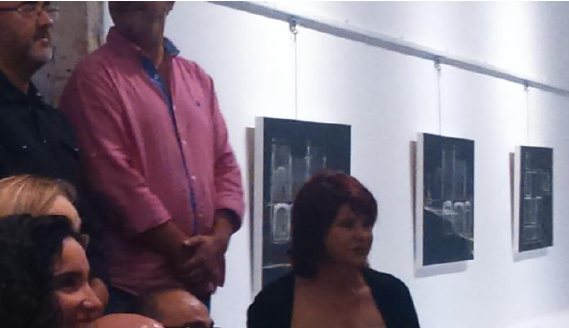
Figure 20. Public exhibition where point clouds were transformed in